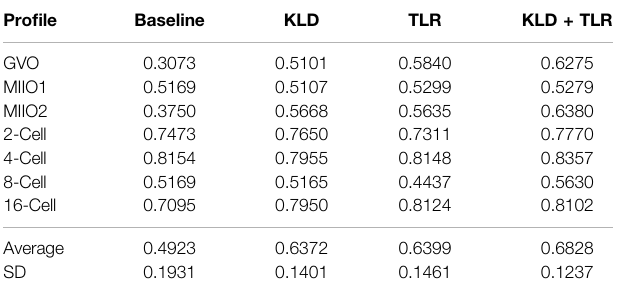
TABLE 4 | F1 score of models trained for target pro fi les using different objective functions and with/without transfer. Pro fi le Baseline